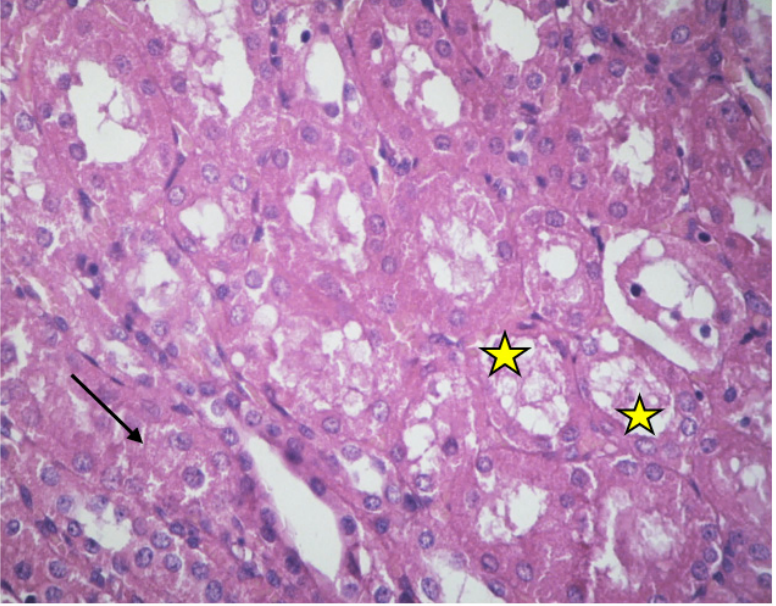
Figure 2. Cortex of non-resuscitated swine stained with HE. Destroyed tubular epithelium and amorphous material fills the tubular lumen (yellow stars). Expanded connective tissue (black arrow), ×160. There was also excessive connective tissue at several sites (Figures 2 and 3).